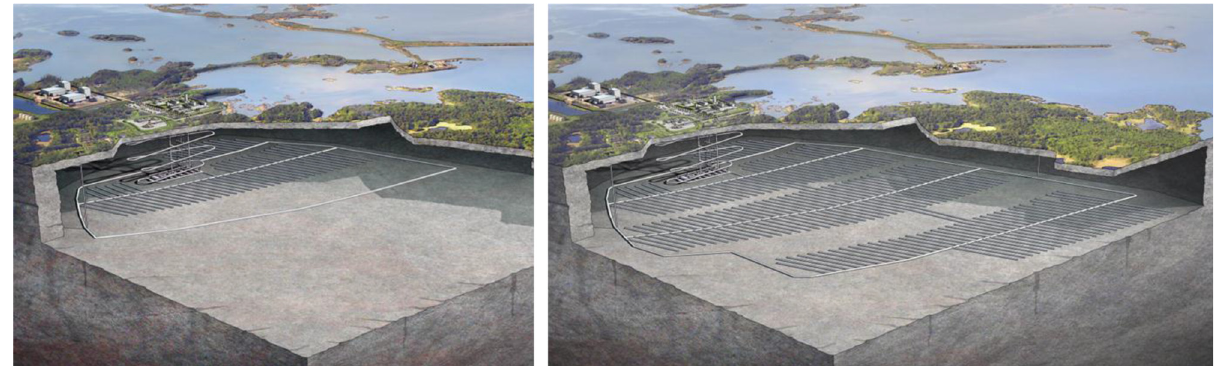
Fig. 2. During operation parts of the repository will already have been constructed, characterised and fi lled with deposited canisters, whereas other parts are yet to